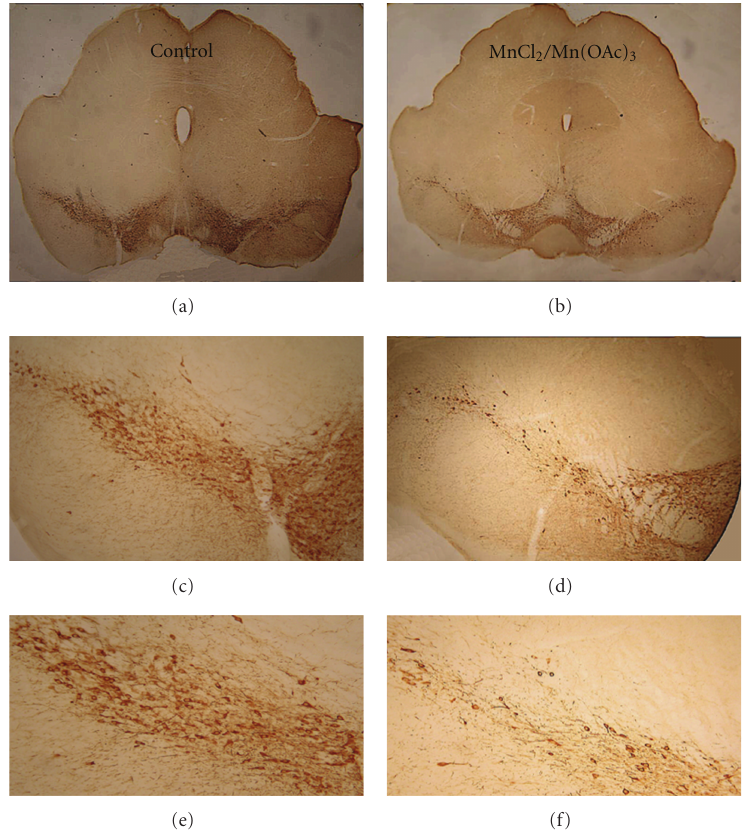
Figure 9: Representative TH-immunostained from coronal section containing the SN and VTA of control and Mn-exposed mice. Note the relative sparing in the ventral tegmental area and profound cell loss at all levels of SNc in the Mn-exposed group (upper panel 4x, middle panel 10,000x, and lower panel